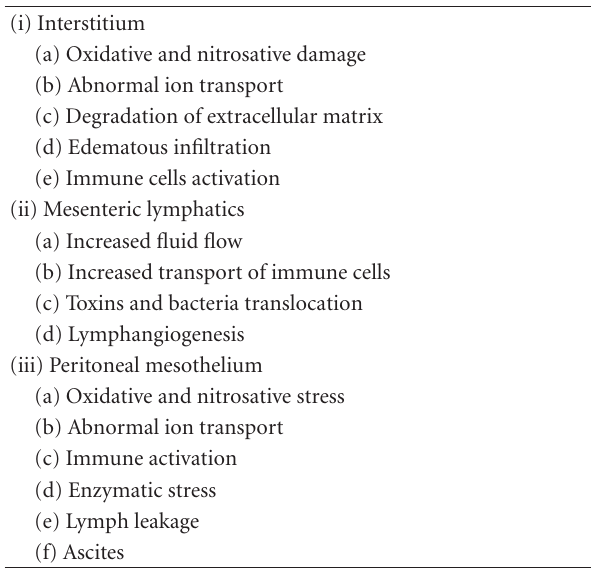
Table 3: The continuum inflammatory splanchnic pathway of Portal